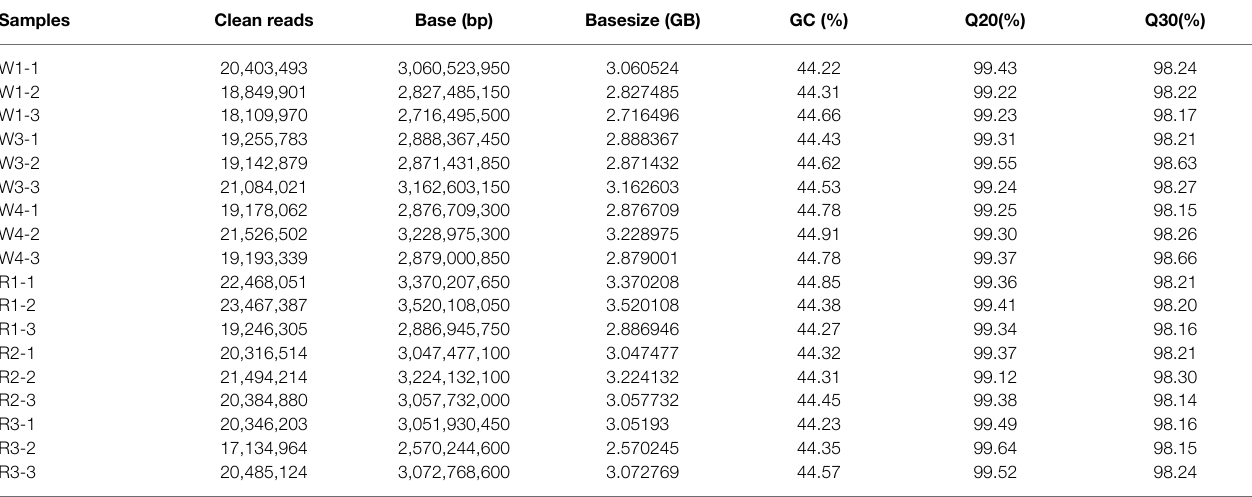
TABLE 1 | Summary of sequencing data. Samples